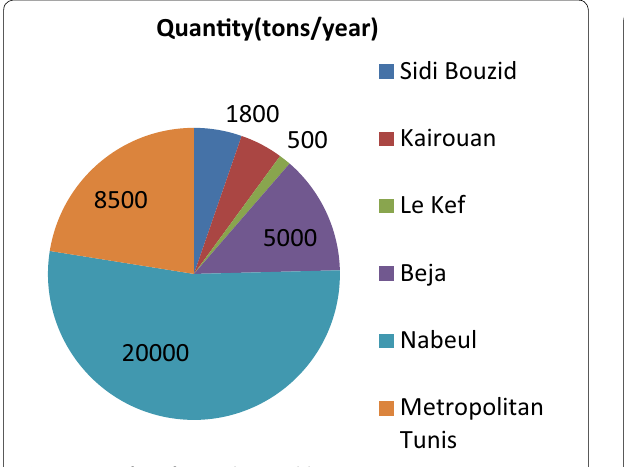
Fig. 4 Waste from fruit and vegetable canneries Fig. 5 Quantity of